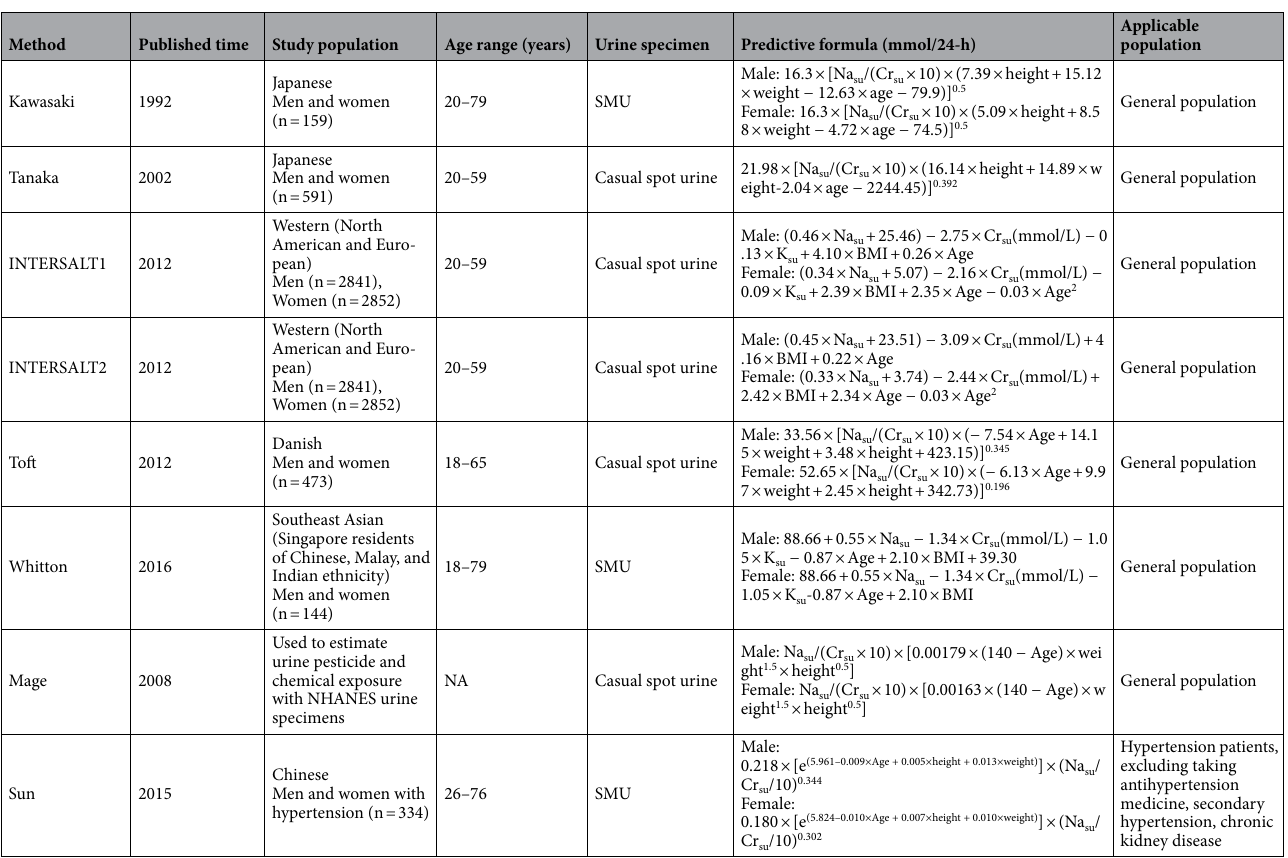
Table 1. Equations for 24-h urinary sodium excretion based on single spot urine samples. The units of concentration for Na su and K su were all mmol/L; unless otherwise specified, the units of Cr su were mg/dl. The units of weight and height were kg and cm. SMU second morning urine, Na su Spot urinary sodium, K su Spot urinary potassium, Cr su Spot urinary